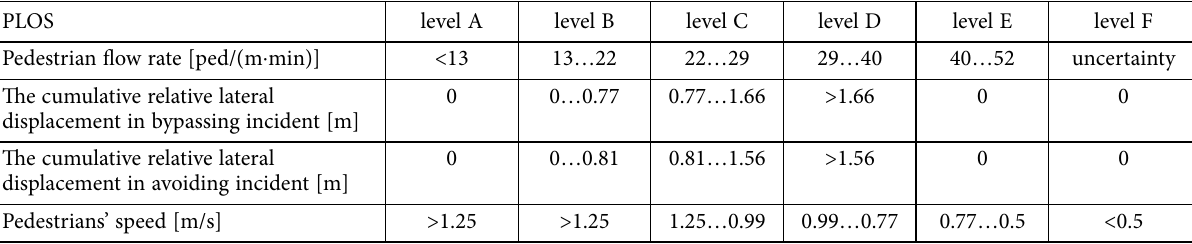
Table 2. The comparison of the threshold of each level of pedestrian flow rate and pedestrians’ behaviour indexes PLOS